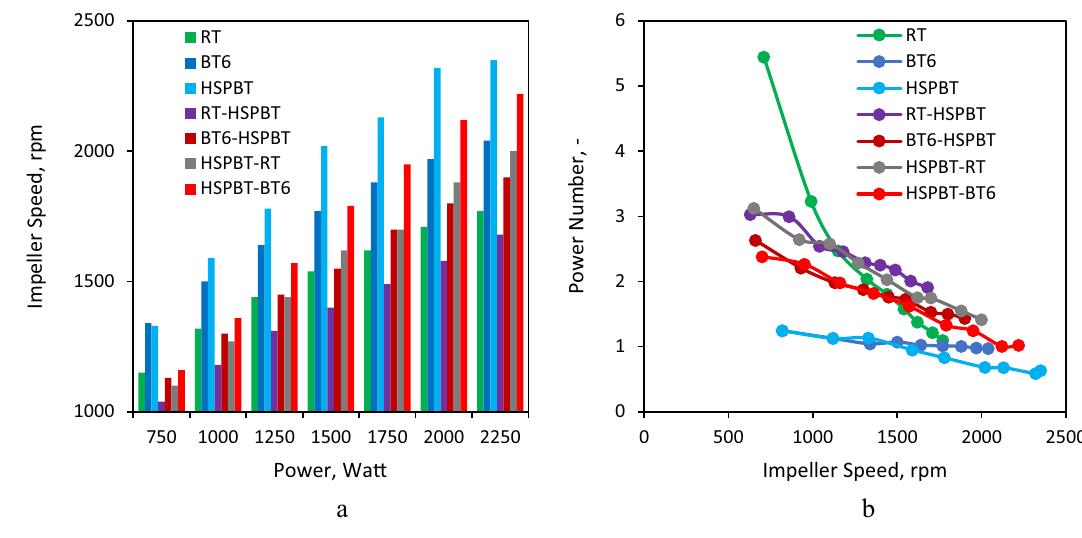
Fig. 4 a Impeller speed with applied power for different impeller combinations for aqueous foams. b Power number with applied mixing speed for different impeller combinations for aqueous foams